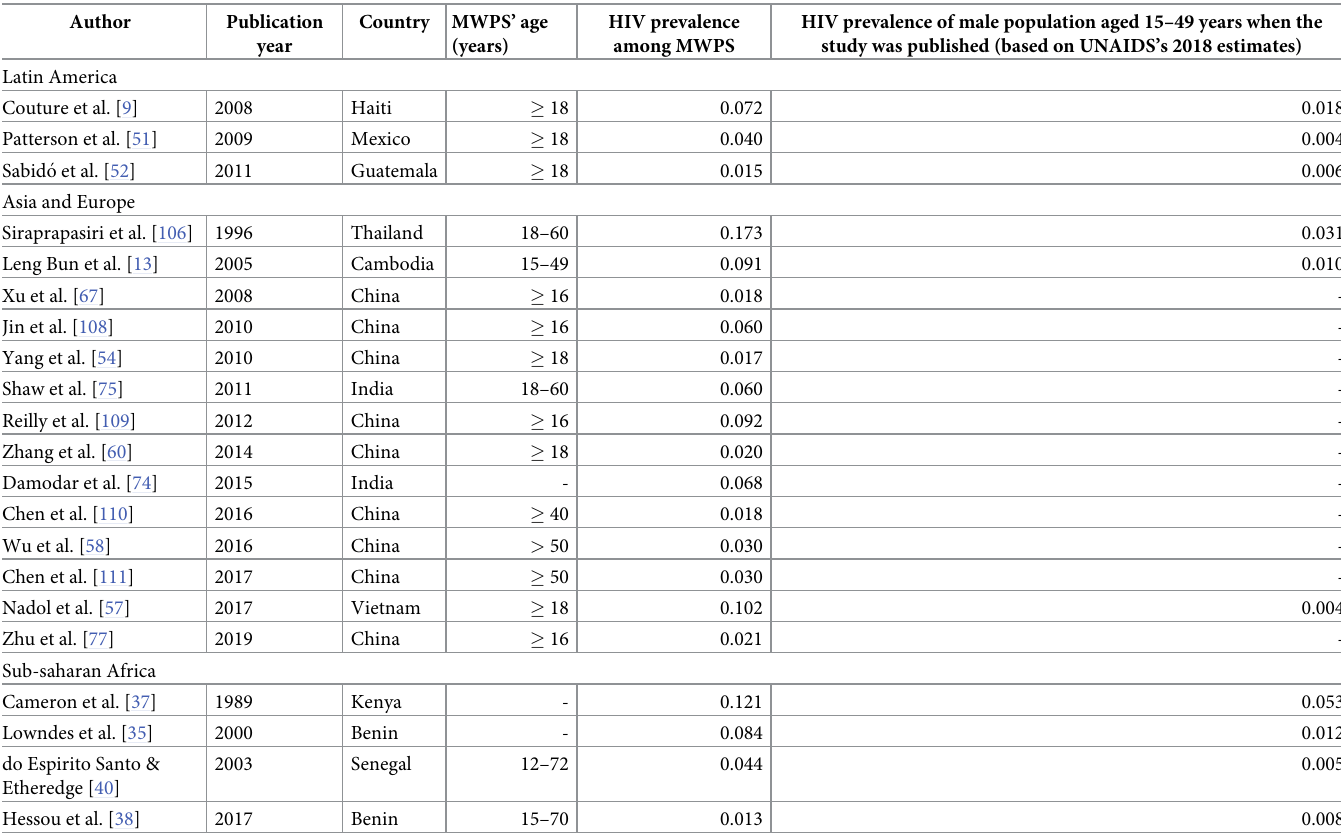
Table 3. HIV prevalence among MWPS and male population aged 15–49 years in the corresponding country when the study was